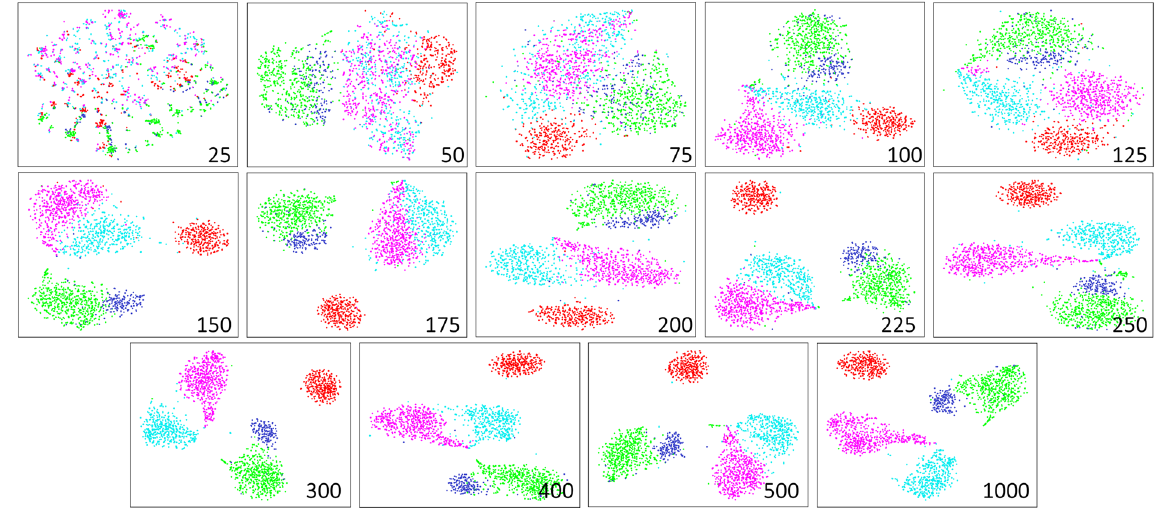
Figure 8. Background Tumor Classification Potential Revealed by Random Transcript Subsets of Sufficient Size. t-SNE embeddings of random subsets of the tumor gene expression matrix are presented at various sample sizes. Top row, left to right: subsets of size 25, 50, 75, 100, 125; middle row: subsets of size 150, 175, 200, 225, 250; bottom row: subsets of size 300, 400, 500, 1000. Sample colors are as follows: BLCA, light blue; GBM, dark blue; LGG, green; OV, red; THCA,